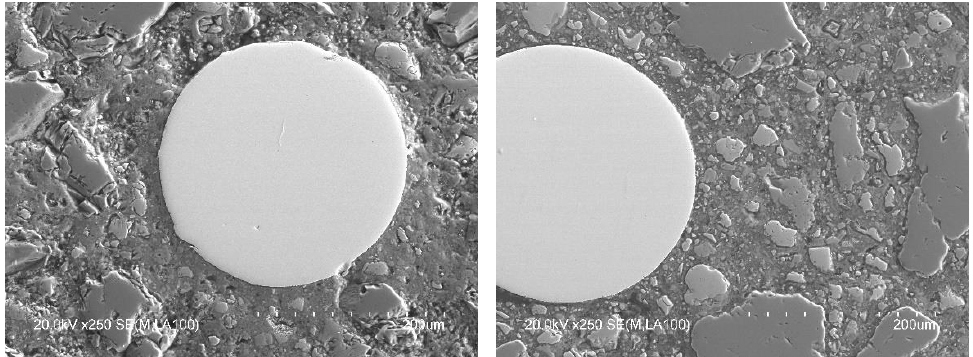
Figure 14. Detail of the fiber-matrix interface and appearance of the matrix component phases.